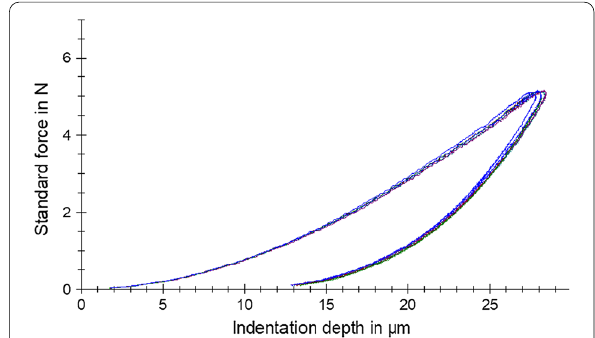
Fig. 2 Representative force-indentation depth curves from both groups tested